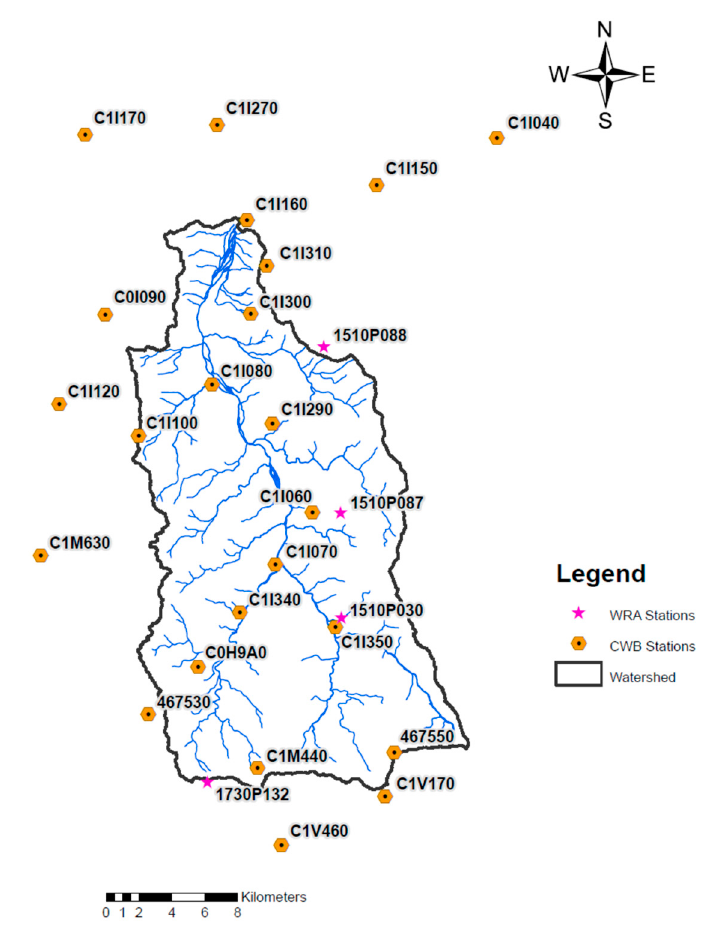
Figure 2. Locations of rain gauges in the Chenyulan river watershed and surrounding regions.